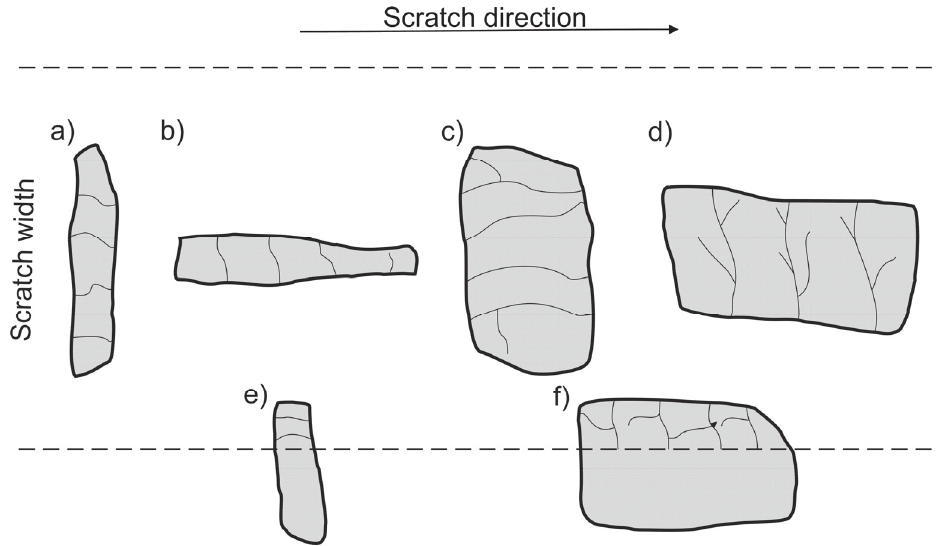
Figure 14. Schematic representation of cracks in SiC particles depending on their size, shape (geometry), and orientation relative to the scratching direction: ( a ) elongated particle with transversal orientation; ( b ) elongated particle with longitudinal orientation; ( c ) globular particle with transversal orientation; ( d ) globular particle with longitudinal orientation; ( e ) elongated particle on the scratch edge; ( f ) globular particle on the scratch edge.